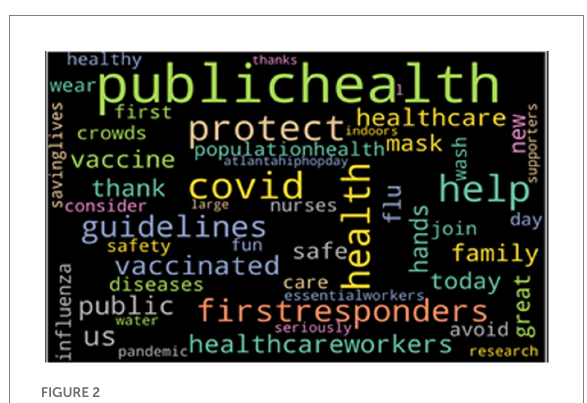
FIGURE 2 The top 50 keywords from positive